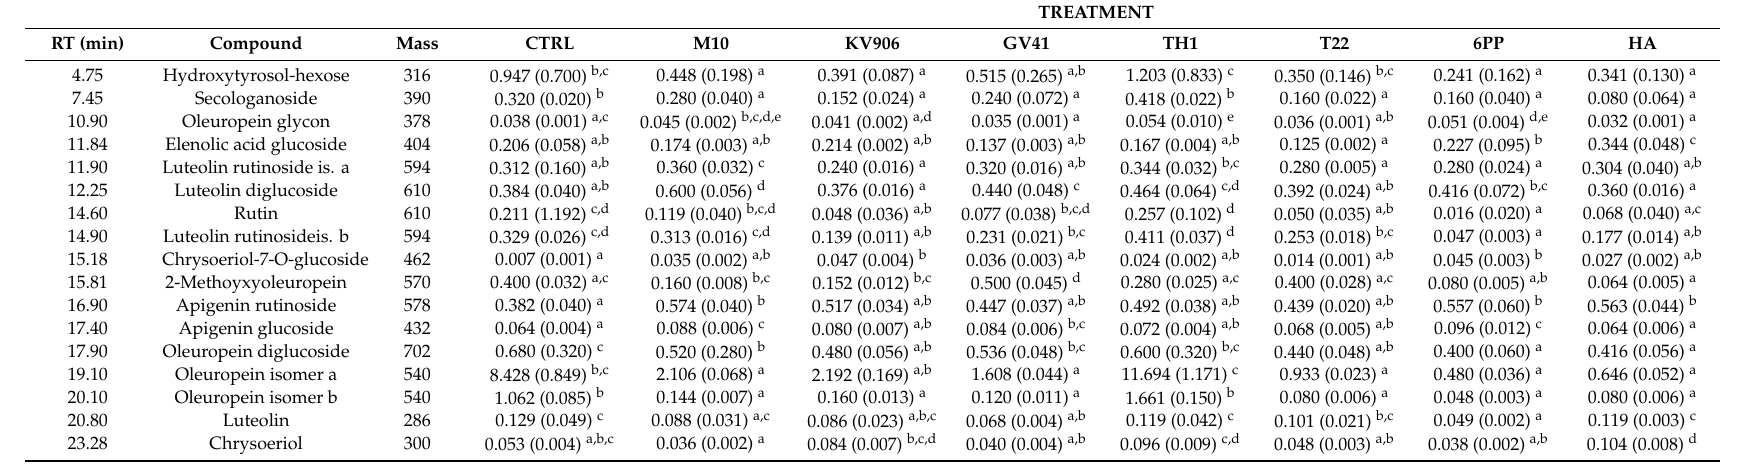
Table 3. Phenolic compounds detected in leaf extracts of olive plants subjected to field applications of Trichoderma strains (M10, KV906, GV41, TH1, and T22) or secondary metabolites (HA and 6PP). CTRL = samples from water-treated plants. Values are expressed as mg g − 1 of dry olive leaves and standard deviation (in parenthesis). Di ff erent letters in a row indicate statistically significant di ff erences (one-way ANOVA at the 0.05 level of